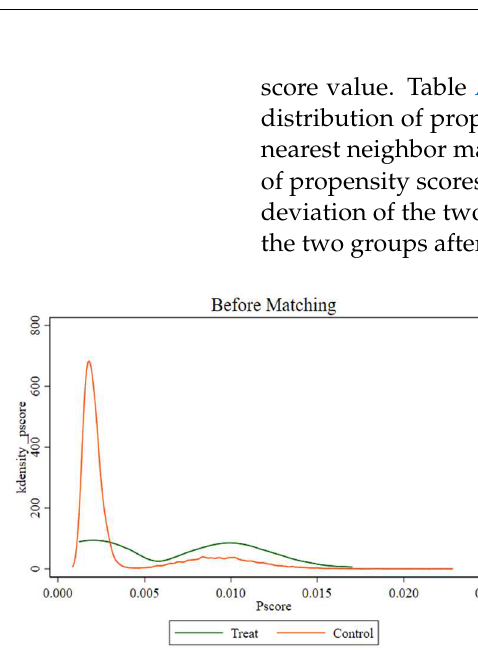
Figure 1. Kernel density propensity score before and after matching.